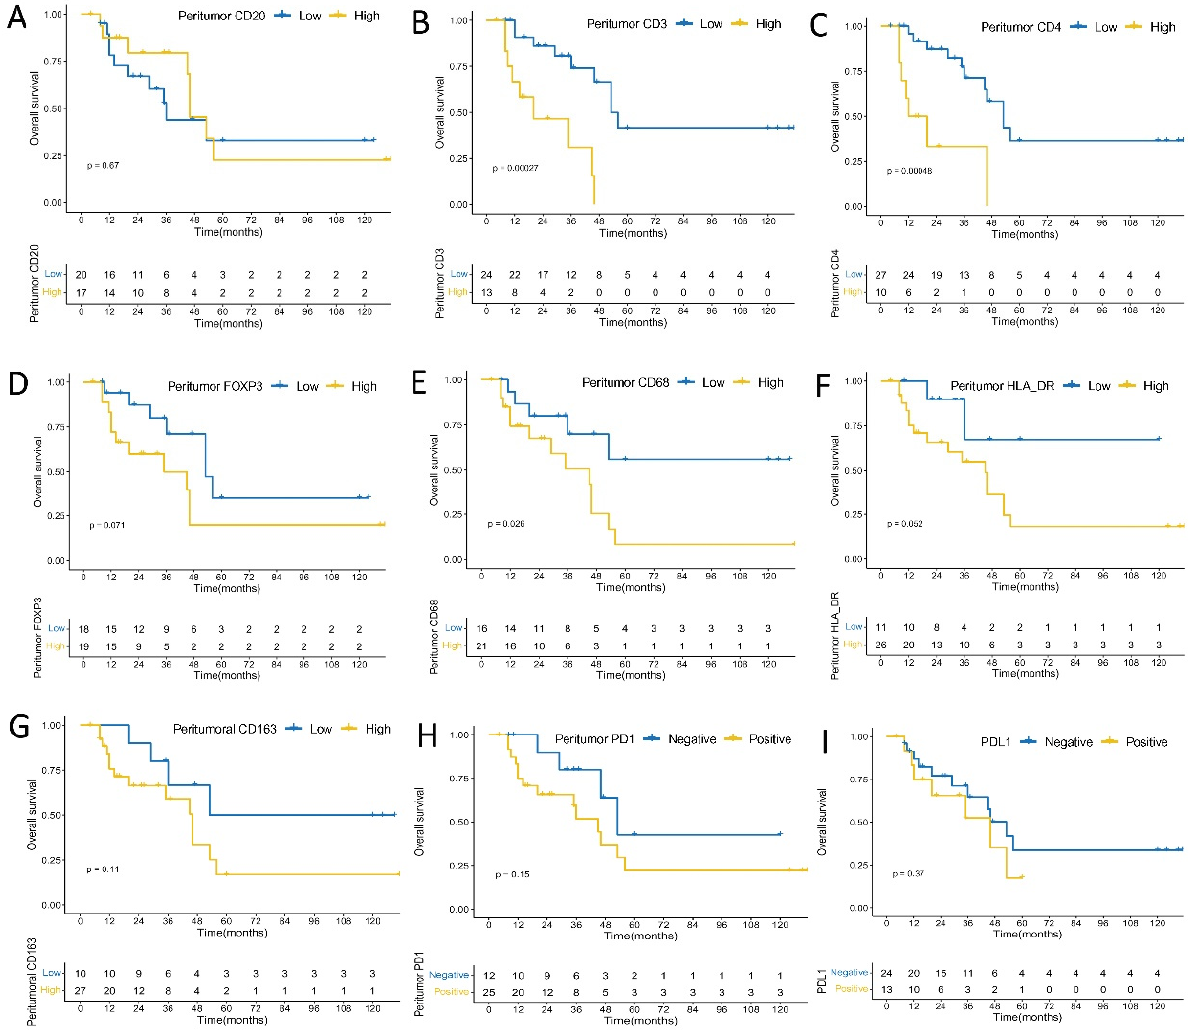
Figure 3. Kaplan–Meier analysis of peritumoral immune cells, PDL1 expression on immune cells and overall survival. ( A ) CD20; ( B ) CD3; ( C ) CD4; ( D ) FOXP3; ( E ) CD68; ( F ) HLA-DR; ( G ) CD163; ( H ) PD1; ( I ) PD-L1 expression.